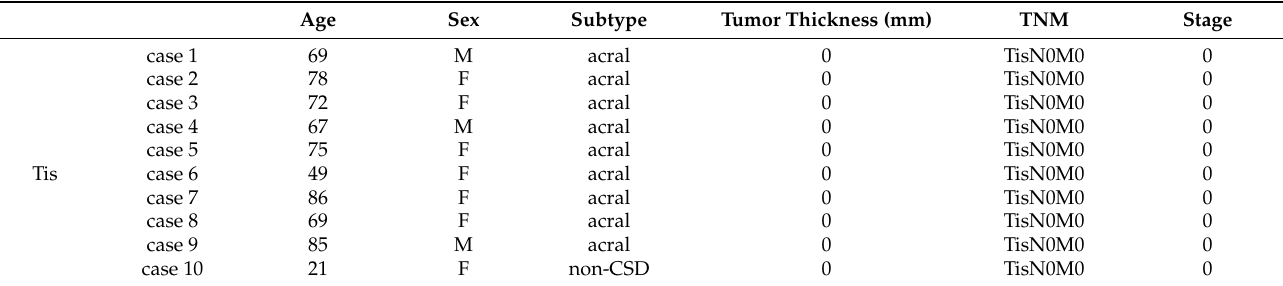
Table 1. Characteristics of patients with